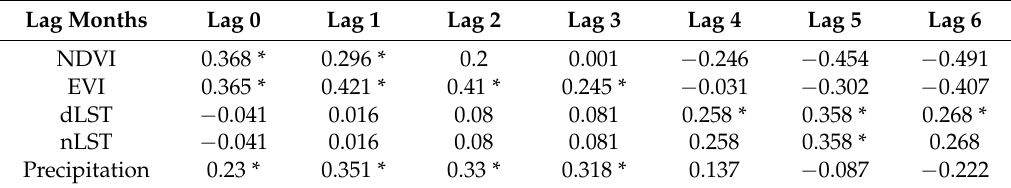
Table 4. Cross correlation analysis between dengue fever cases and selected remotely sensed environmental variables at different lag period, Chitwan, Nepal (* p <